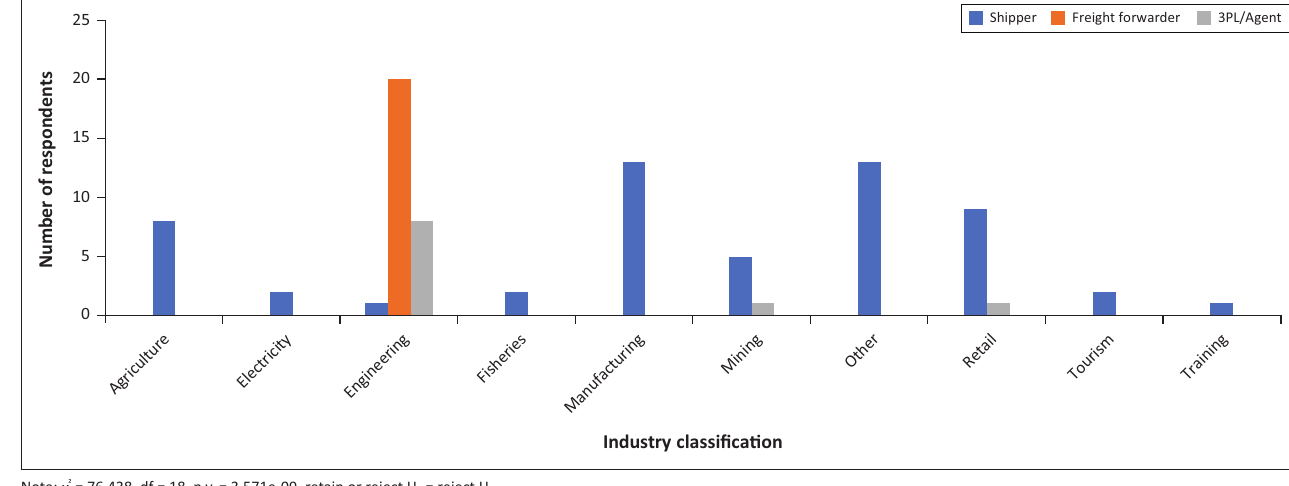
FIGURE 3: Decision-maker by company size.